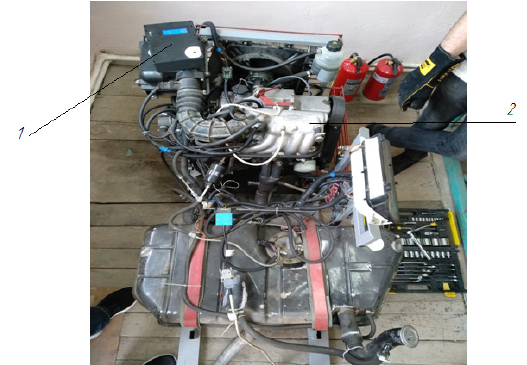
Figure 7. The experimental setup: 1 - loader of the DBD ga– soline engine; 2 - power plant based on the VAZ-2114